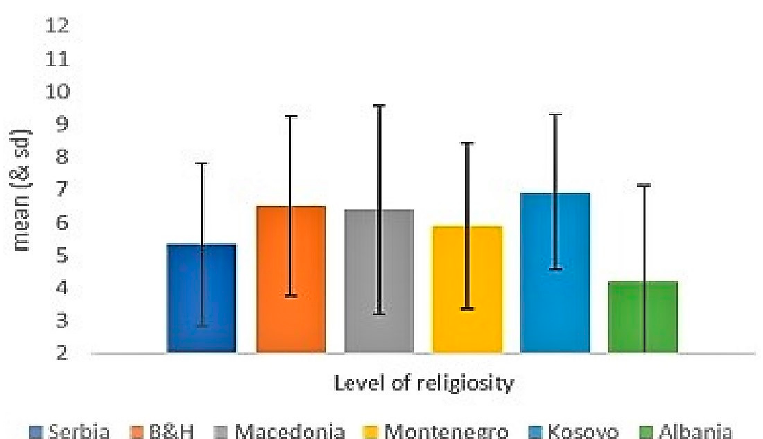
Figure 5. Level of religiosity by country. (The error bars represent standard deviation).